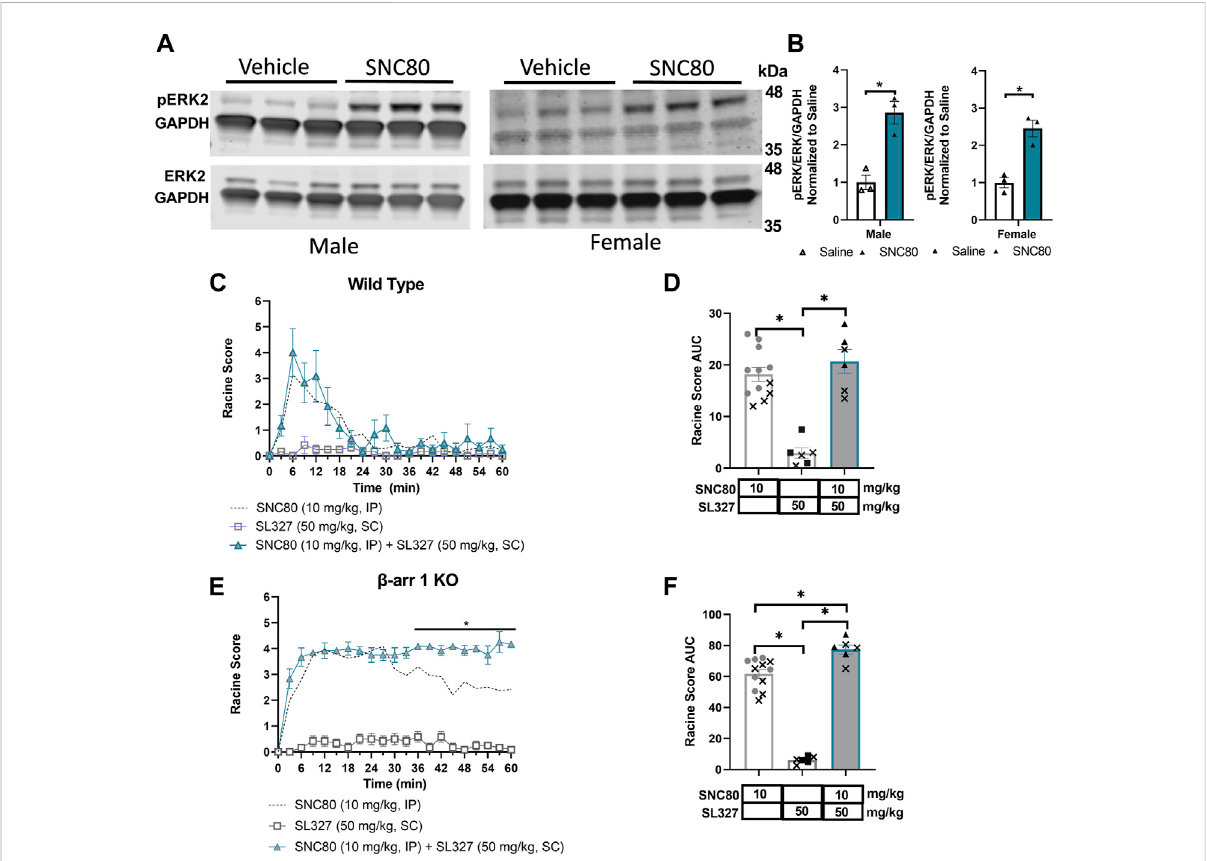
FIGURE 4 ERK activation by SNC80 does not cause seizures. (A) Representative western blot of SNC80 (10 mg/kg, i.p.)-induced activation of ERK in hippocampaltissuefrommale andfemale β -arrestin 1KOmicerelativetovehicle(n=3pertreatment andsex). (B) Quanti fi cationofphosphorylated ERK(pERK)overtotalERK(ERK)allnormalizedtoGAPDHasloadingcontrol.Seizureactivityovertime (C,E) andasareaunderthecurve(AUC) (D,F) in wild-type (C,D) or β -arrestin1KO (E,F) miceexposedtoSNC80(10mg/kg,i.p.),SL327(50mg/kgi.p.)orSNC80+SL327.Equalnumberofmales andfemalestested(n=6total).*p < 0.05.Dottedlinedepicts10mg/kgSNC80inwild-type (C) or β -arrestin1KOmice (E) forreference.In (D,F) male mice are depicted with a cross, whereas female mice are depicted as solid